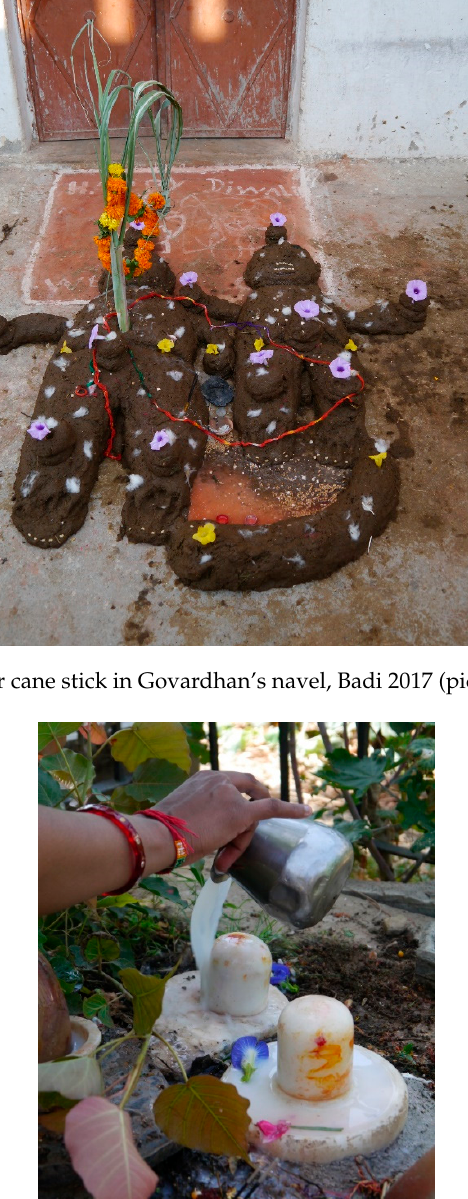
Figure 14. Water pump in Badi, 2017 (picture by author). What is more, women do not put the tall sugar cane at a random spot in the cowdung figure but right in the middle of an equally disproportionally big navel ( nabhi ). Rising up from the navel, the cane looks like an umbilical cord, feeding and sustaining new life. Although the women did not explicitly mention this, and some even said they put the cane there for no other reason than that it was the most solid part of the cowdung figure, the navel is a recurring key symbol in Hinduism as well; it generally refers to the birth of the universe and the divine world. The navel is also one of the seven chakra’s , energy centres in human bodies which are considered in Hindu health and yoga practices. It is significant that this particular navel chakra is linked to the goddess Lakshmi who reigns over Divali, refers to riches and abundance, and is associated with fertility and the potency of the earth (Elgood 2000, pp. 75–76). Putting the sugar cane into the navel is thus an act of visualising Lakshmi, making her strong and beautiful, and activating her as a bringer of good luck and fertility. The reference to fertility and family building is explicitly visible in the variations some women made on the figure of two male figures. Instead of two male figures, there sometimes was a male figure (with a penis) and a female figure (with breasts) with the sugar cane put in the woman’s navel. One woman deviated from the two-figure composition by modelling three human figures representing a complete family: a father, mother and male child in between (Figure 15). These deviations show how women translate the mythical images of gods and landscapes into familiar images of family prosperity and fertility.